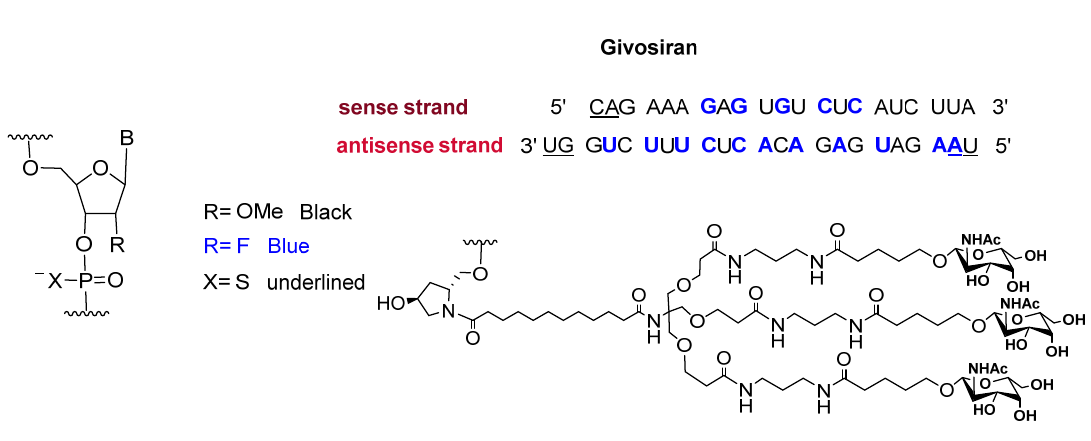
Figure 3. Chemical structure of givosiran (Givlaari TM ) [13].